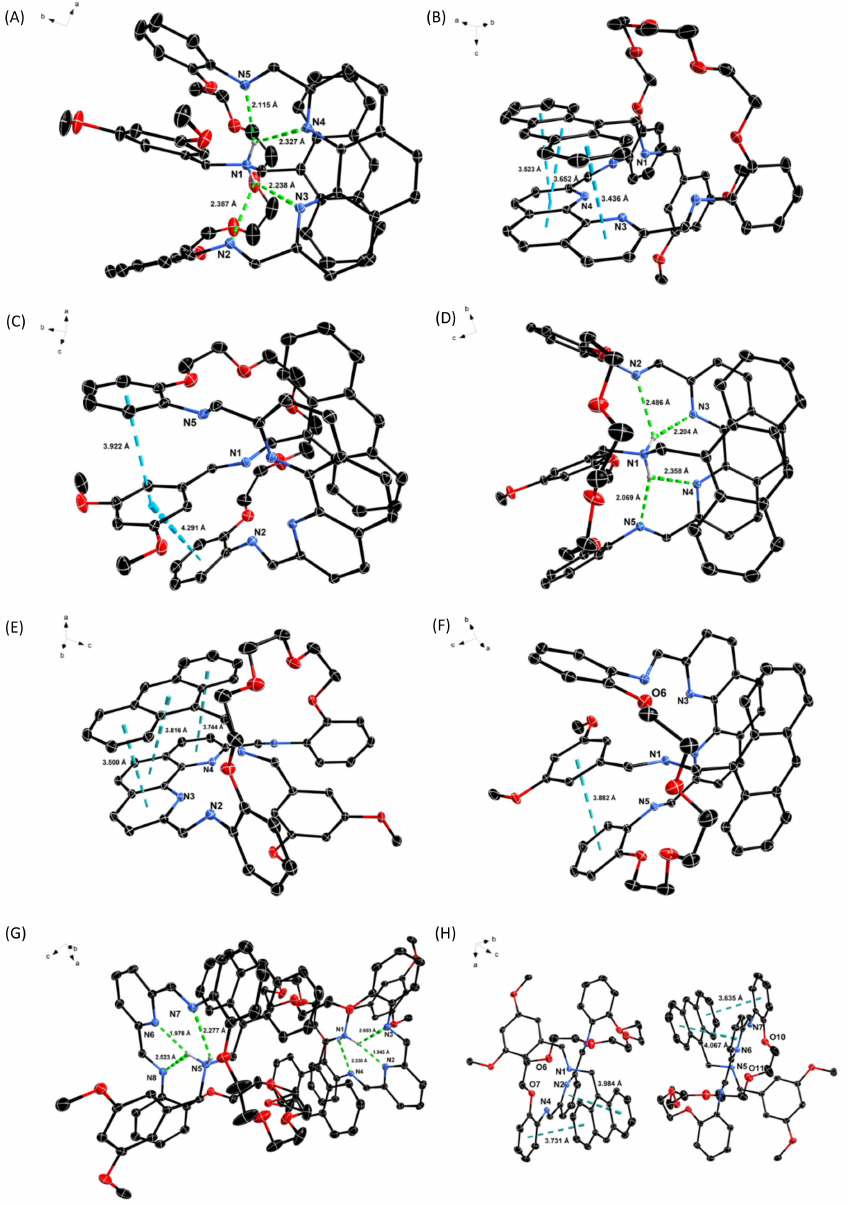
Figure 2. Perspective view of ( A ) solid-state structures of dynamic rotaxane 8 -H · PF 6 (CCDC code: 1993136); ( B ) the offset face-to-face π – π stacking intercomponent interaction between the anthracene and phenanthroline in 8 -H · PF 6 ; ( C ) the offset face-to-face π – π stacking intercomponent interaction between the phenyl moieties in 8 -H · PF 6 ; ( D ) solid-state structures of dynamic rotaxane 9 -H · PF 6 (CCDC code: 1993139); ( E ) the offset face-to-face π – π stacking intercomponent interaction between the anthracene and phenanthroline in 9 -H · PF 6 ; ( F ) the offset face-to-face π – π stacking intercomponent interaction between the phenyl moieties in 9 -H · PF 6 ; ( G ) solid-state structures of dynamic rotaxane 10 -H · PF 6 (CCDC code: 1993140); ( H ) the offset face-to-face π – π stacking intercomponent interaction between the anthracene and pyridine in 10 -H · PF 6 . All hydrogen atoms and PF 6 – anions are omitted for